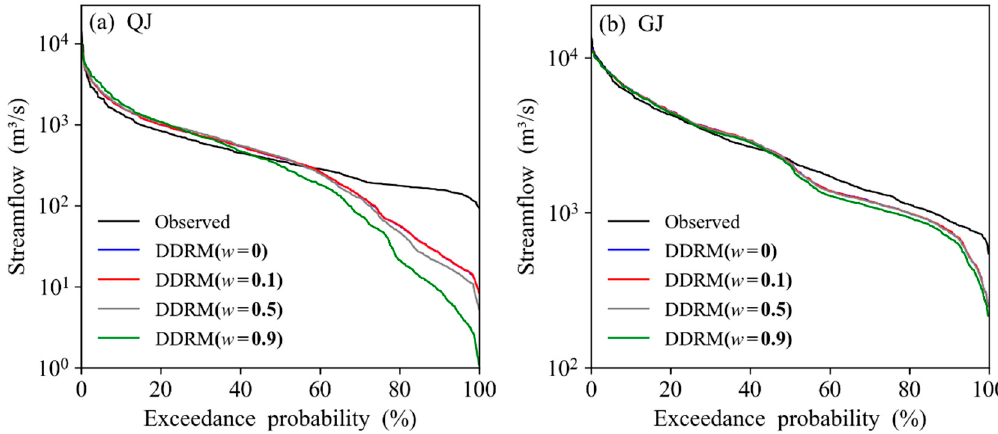
Figure 5. Comparison of the observed and DDRM-simulated flow-duration curve during the calibration period (2015 – 2017) for ( a ) QJ and ( b ) GJ.